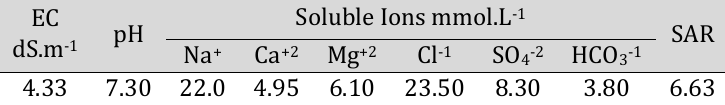
Table 2. Prope rties of ir rigati on water us ed in t h e